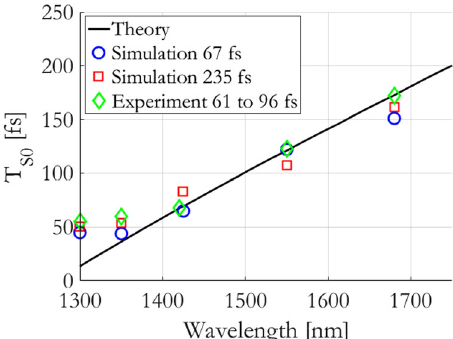
Fig. 7 Theoretical curve of soliton pulse duration vs. wavelength, compared with measured and simulated soliton pulsewidth. Experiments carried out with 1 m of graded-index (GRIN) fi ber, with input wavelength and pulsewidth: 1300 nm and 61 fs, 1350 nm and 61 fs, or 1420nm and 70 fs, respectively. Experiment carried out with 6 m of GRIN fi ber, with input wavelength and pulsewidth: 1550 nm and 67 fs, 1680 nm and 96 fs, respectively. Measurement error comes directly from the instrument accuracy, which is below 1%. Simulations were carried out with same distances and input wavelengths as in the experiments, with pulsewidths of 67 and 235 fs,